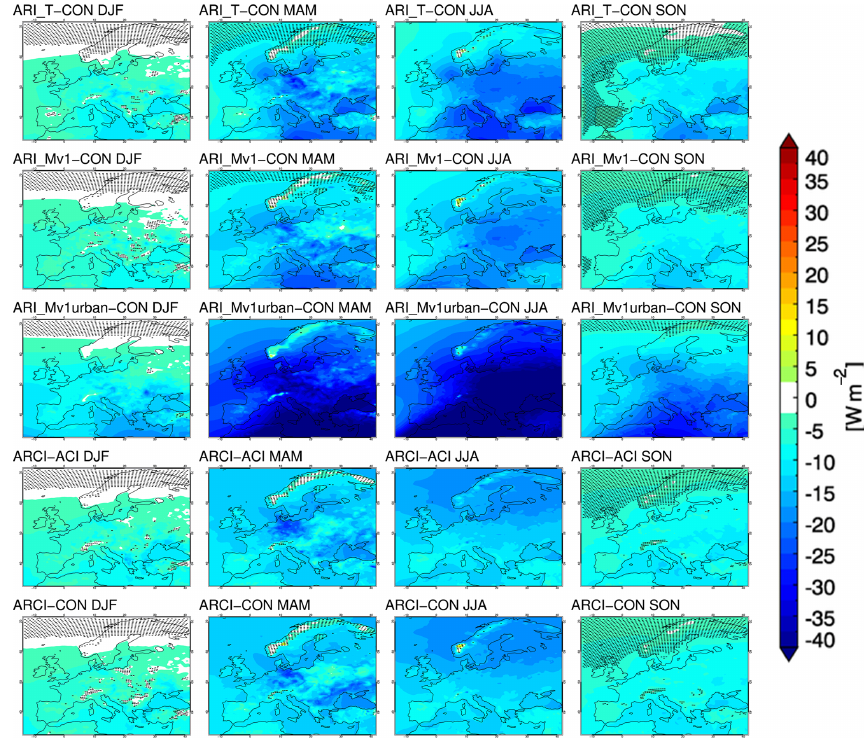
Figure 4. Clear-sky direct radiative effect (cs-DRE) at the surface for all seasons. Rows 1–3: for selected ARI group simulations (ARI_T, ARI_Mv1, ARI_Mv1urban) that implement only aerosol–radiation interactions. The cs-DRE has been calculated as the difference in netCrsds at the surface from control CON and depicts the impact of aerosol–radiation interactions only. The fourth row depicts the aerosol–radiation interactions in an environment where the indirect effect is also present and displays the difference of experiment ARCI to ACI. The bottom row depicts the impact of aerosol–radiation interactions plus the impact of the TE2014 microphysics scheme with aerosol–cloud interactions. It displays the difference of experiment ARCI to CON. Stippling indicates areas where the differences are not statistically significant at the 95% level, according to the Mann–Whitney non-parametric